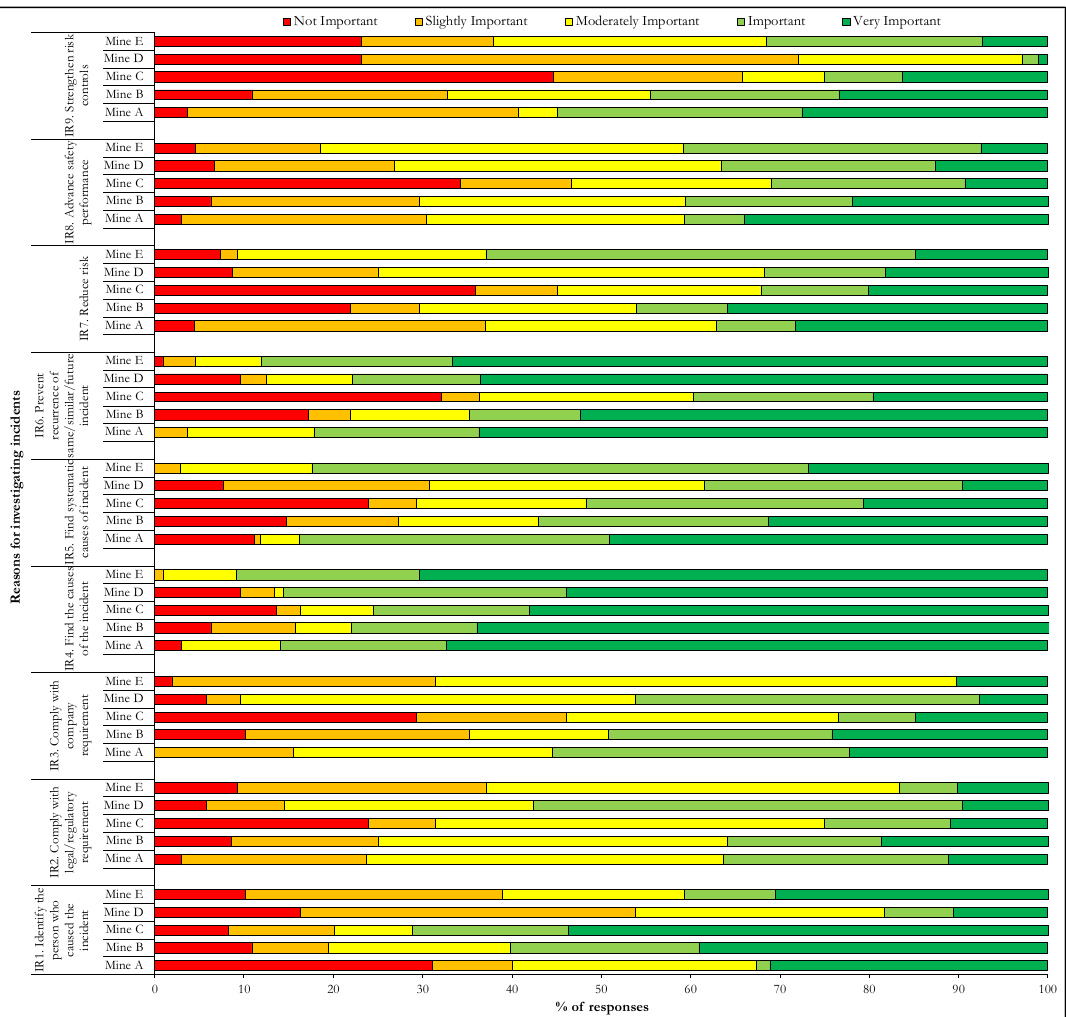
Figure 5. Comparison across mines of how important survey participants perceived the reasons for investigating incidents.